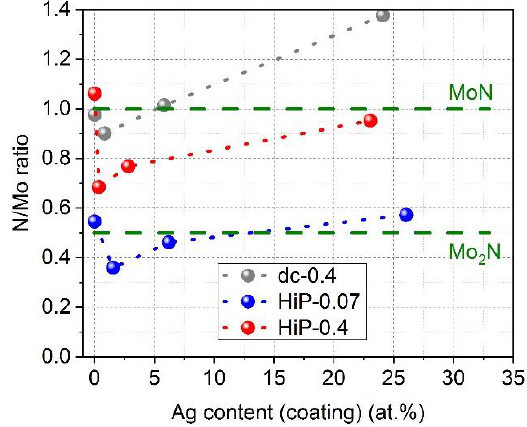
Figure 6. N/Mo ratio vs. Ag content of the coatings as measured by WDX. The horizontal dashed lines (olive color) indicate the N/Mo ratio of stoichiometric Mo 2 N and MoN films.